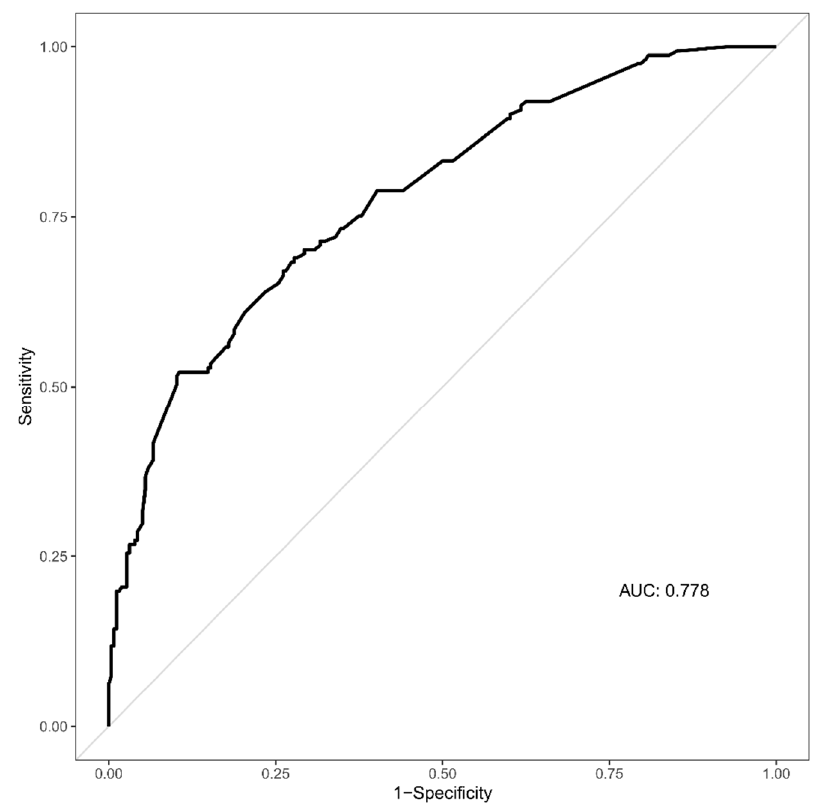
Figure 2. Receiver operating characteristic curve of the multivariable logistic regression predicting epilepsy development in pediatric patients with afebrile seizures.